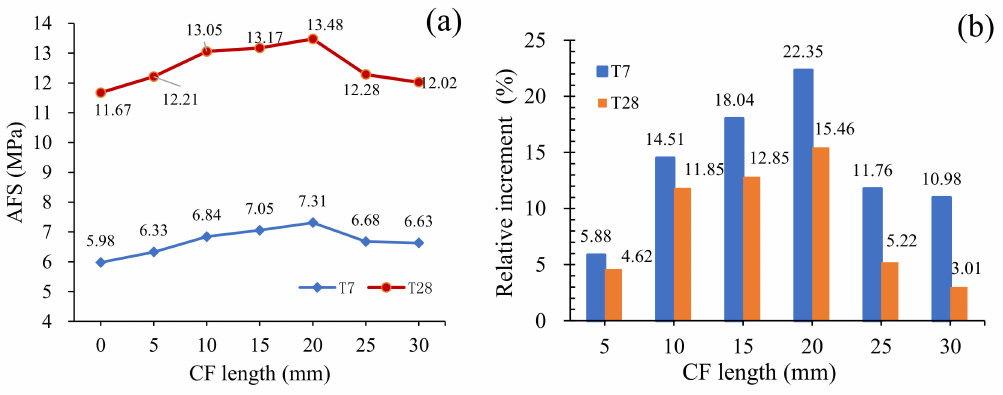
Figure 9. Average flexural strength: ( a ) AFS; ( b ) Relative increment of